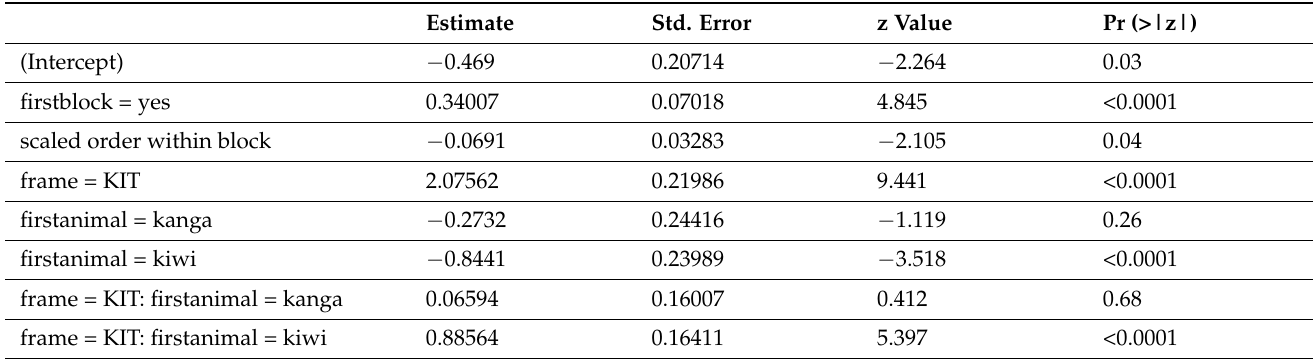
Table 5. Selected model for experiment one (dependent variable = KIT-consistent response. Intercepts = participant and